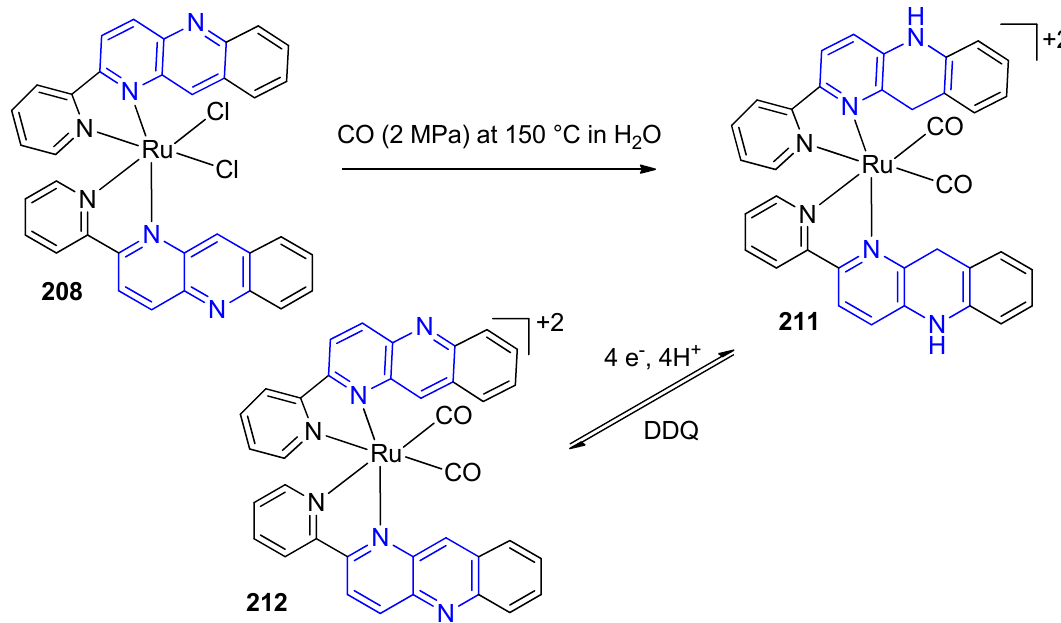
A four-electron-reduced ruthenium(II) NADH-type complex, [Ru(bbnpH 4 )(CO) 2 Cl](PF 6 ) 213 [Scheme 65, bbnpH 4 = 2,2 ′ -(4-( t -butyl)pyridine-2,6-diyl)bis(5,10-dihydrobenzo[ b ][1,5]naphthyridine)] has been successfully synthesized by using the ligand 10 bbnp (bbnp = 2,2 ′ -(4-(tert-butyl)pyridine- 2,6-diyl)bis(benzo[ b ][1,5]naphthyridine)) and [Ru(CO) 2 Cl 2 ] (Scheme 65) under moderate WGSR conditions (water-gas-shift reaction conditions) in a 1:1 ratio in a 2-methoxyethanol/water